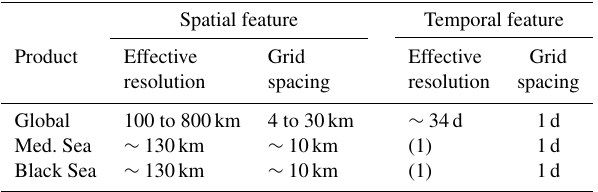
Table 1. Summary of the DUACS products spatial and temporal res- olutions. (1) Not estimated due to the limited amount of tide gauges in the Mediterranean Sea and Black Sea.